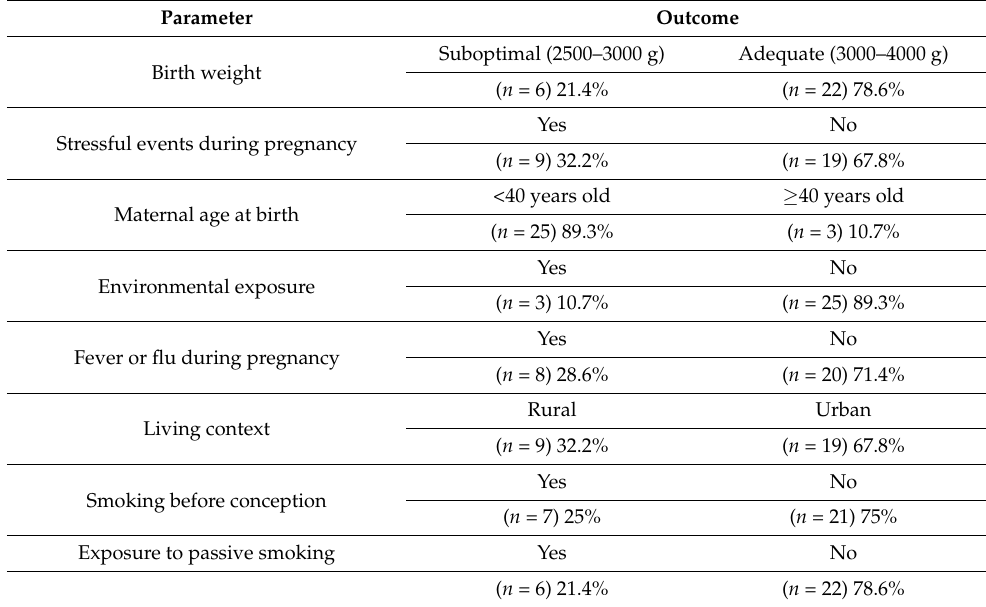
Table 3. Distribution of maternal and newborn data from the study